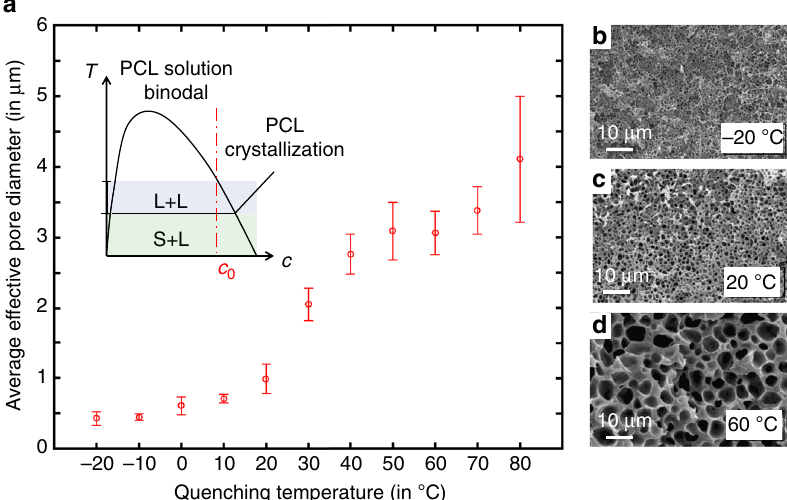
Fig. 3 In fl uence of quenching temperature on microstructure. ( a ) Average pore size for different quenching temperatures in ethylene – glycol – water bath. The error bar corresponds to the SD over the mean pore size in the six images analysed per quenching conditions. The inset displays an illustration of the possible phase diagram with a dashed line at the working concentration, highlighting both L – L and S – L demixing. ( b – d ) Associated cross-sectional SEM images for fi bers quenched at − 20, 20 and 60